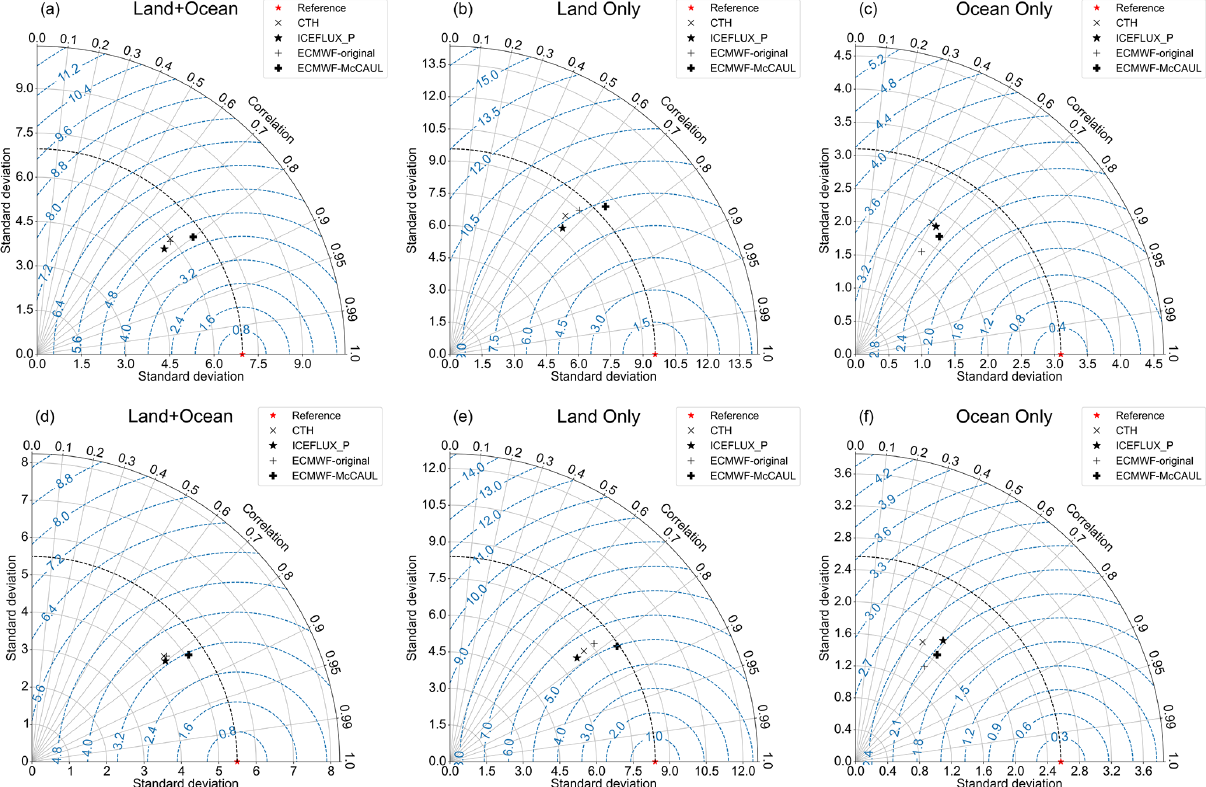
Figure 3. Taylor diagram showing the prediction accuracy of various lightning schemes in 2007–2011 simulations compared to the LIS 2007–2011 lightning climatology (a–c) and the LIS/OTD 1996–2000 lightning climatology (d–f)